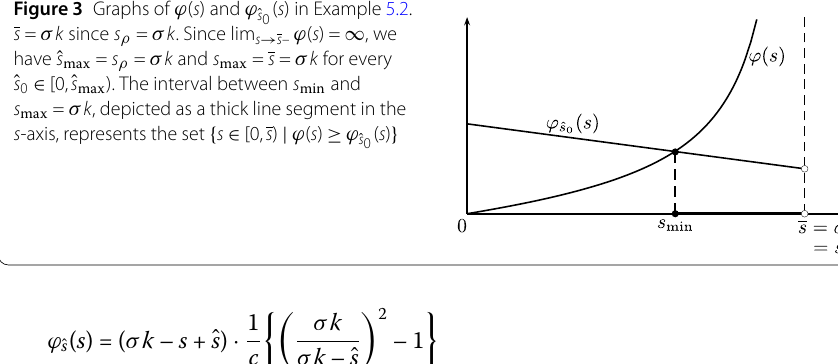
( s ) in Example 5.2. 0